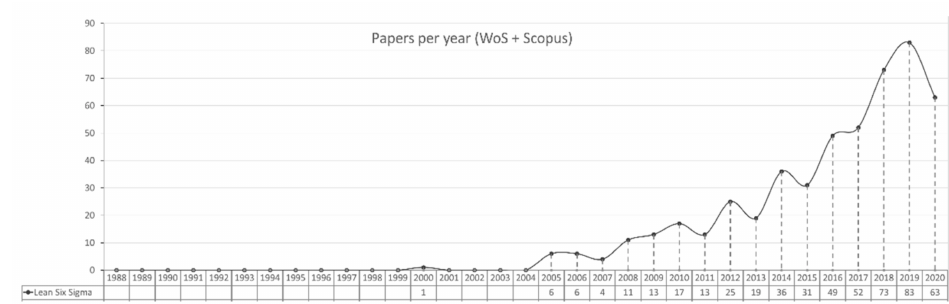
Figure 15. Lean six sigma evolution.